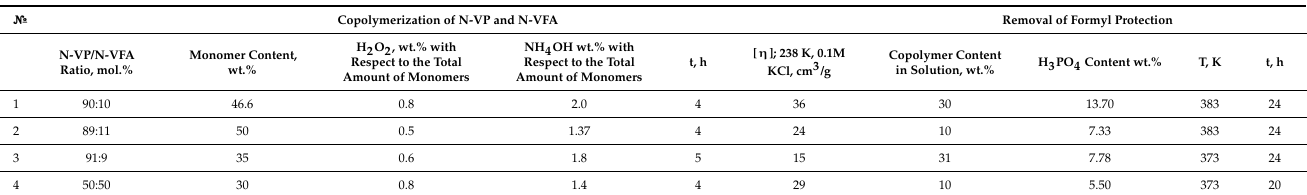
Table 1. Conditions of radical copolymerization of N-VP with N-VFA in the presence of NH 4 OH and H 2 O 2 ; preparation of copolymer [N-VP] n – [N-VA] m X – by acidic hydrolysis with orthophosphoric acid.